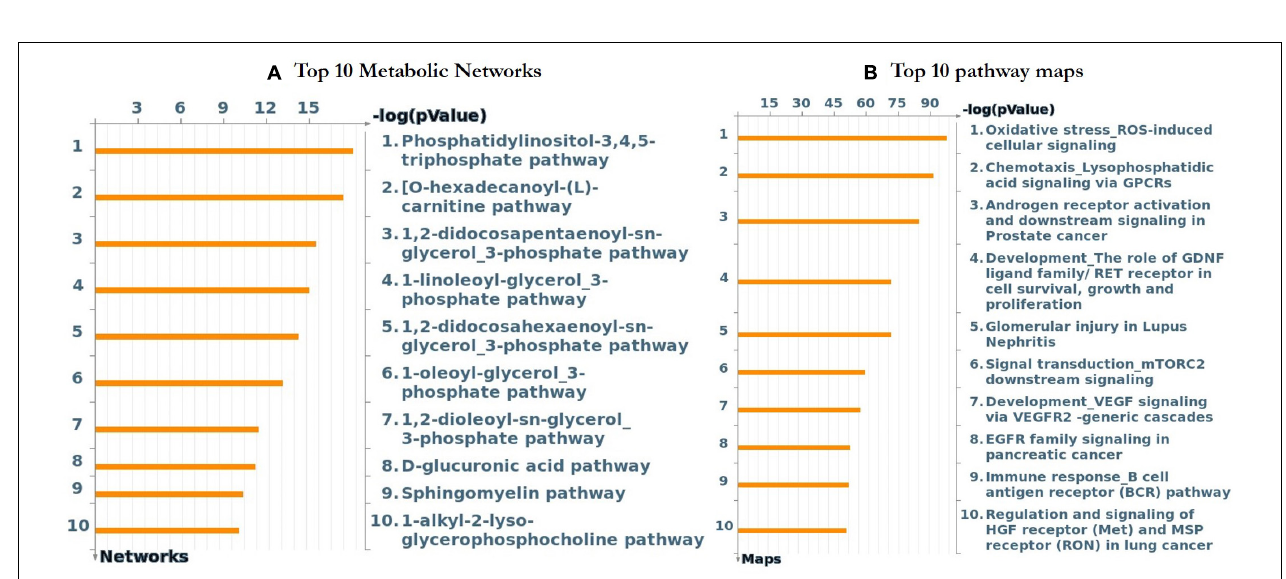
FIGURE 4 | Visualization of Gene Ontology (GO) enrichment profiles from DEGs using Cytoscape software based on network analysis of ClueGO/CluePedia inferred from MCODE cluster 1 (A) and cluster 2 (B) . The plugin provides a combined enrichment analysis of clusters, including the GO biological process, molecular function, and pathway from KEGG. The GO term/pathway network connectivity defined by edges and functional clusters on genes shared between terms (kappa score ≥ 0.4) and displaying pathways only with p ≤ 0.05. The size of the node indicates the p -value. The color code of nodes represents the functional group that they belong to. The most important functional terms specify the pathway names within each class are indicated in bold colored characters. (A) The network enrichment analysis of cluster 1. Each node constitutes a precise term for cluster 1; (B) The network enrichment analysis of cluster 2. Each node constitutes a precise term for cluster 2.